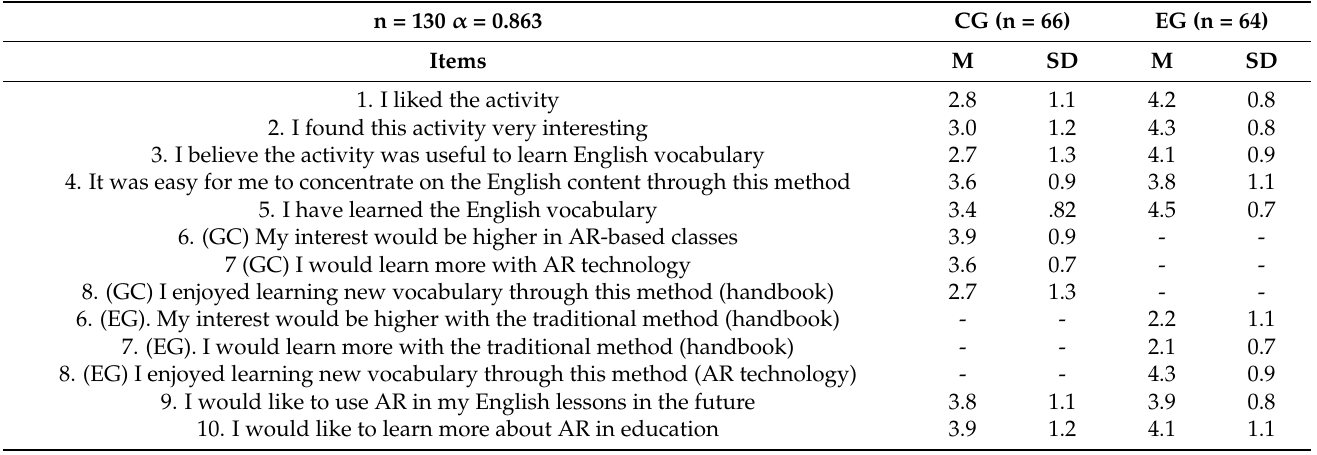
Table 6. Student interest and motivation.